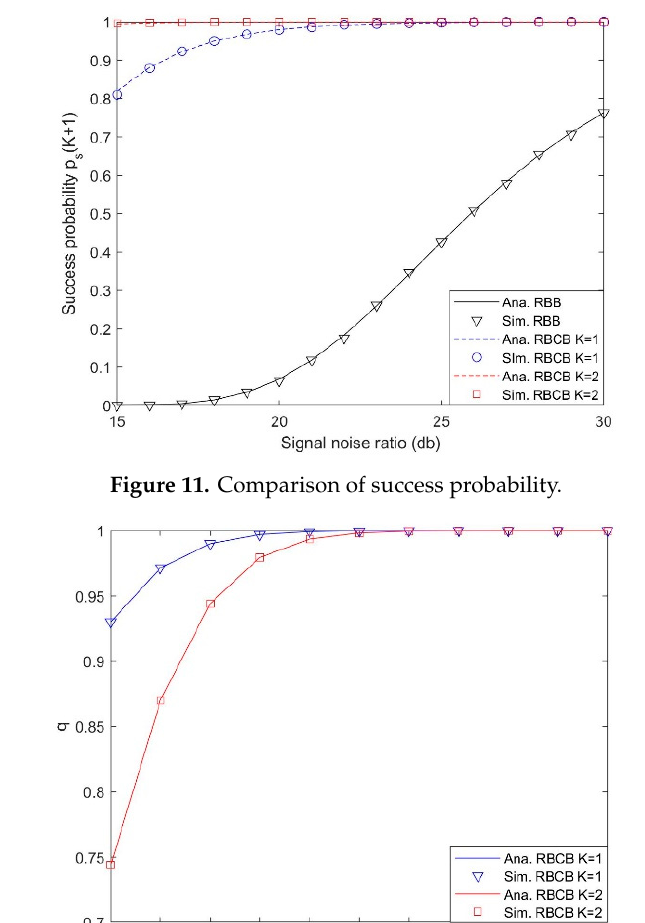
Figure 13. Comparison of PDP for once broadcasting.